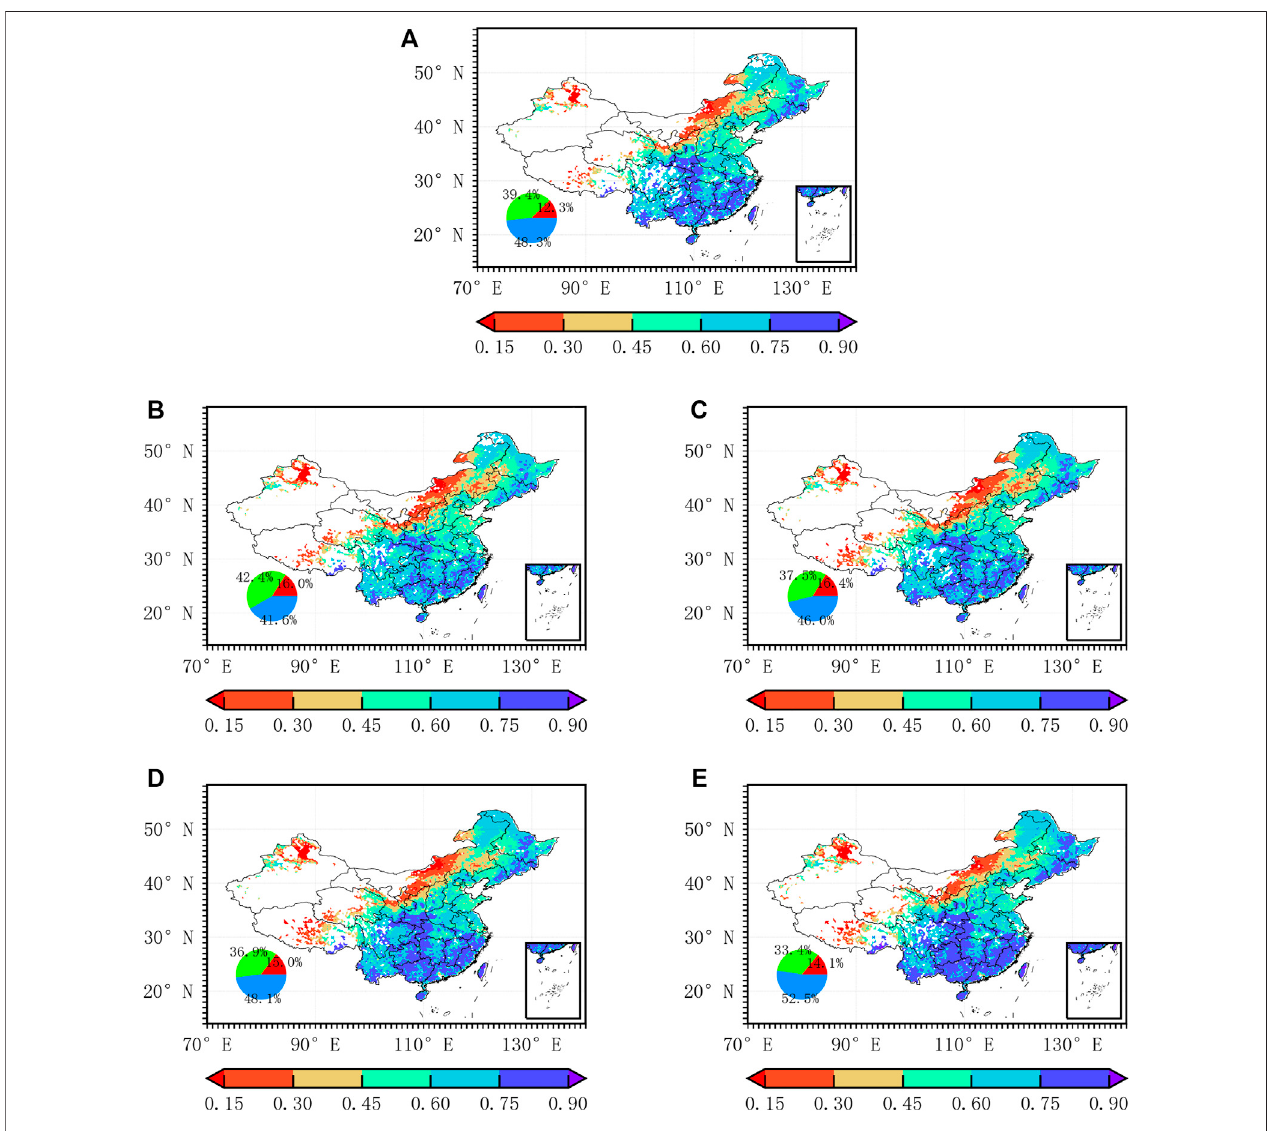
FIGURE 1 | Mean value of vegetation coverage in the growing season for different periods; areas with mean value < 0.05 are blank. (A) 2000 – 2020, (B) 2000 – 2005, (C) 2006 – 2010, (D) 2011 – 2015,and (E) 2016 – 2020.Thepiechartshowstheproportionofhigh,medium,andlowvegetationcoverage,whereblue,green, and red represent high vegetation coverage (0.6 – 1.0), medium vegetation coverage (0.3 – 0.6), and low vegetation coverage (0.05 – 0.3), respectively.